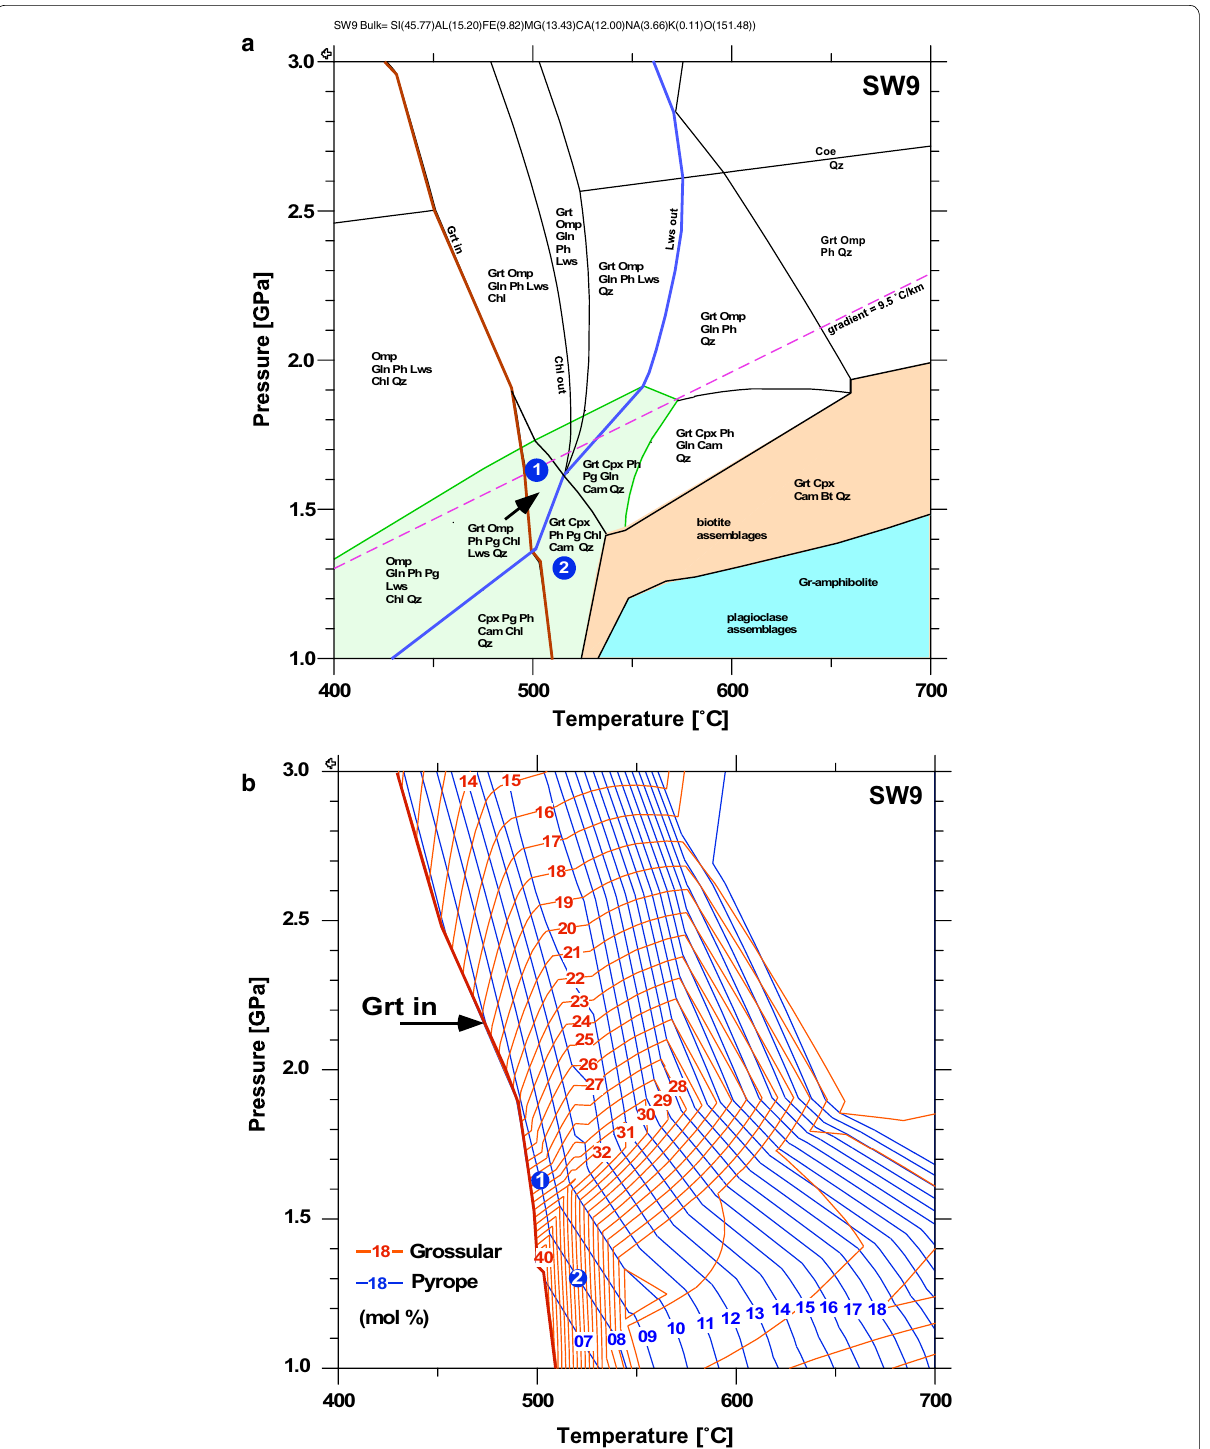
Fig. 6 P – T diagrams for the sample SW9. The SW9 bulk is apatite corrected and ignores TiO 2 and MnO (see text). Models from Domino software (de Capitani and Petrakakis 2010). a Green field for Pg present assemblages. Blue points 1 and 2 are at P – T conditions for the Grt Grs 30 Prp 8 from b . Dashed violett line marks a linear gradient of 9.5 °C/km. b Grt composition isopleths for Grs and Prp with two intersections (blue points) for the measured Grt mantle and rim Grs 30 Prp 8 in the sample